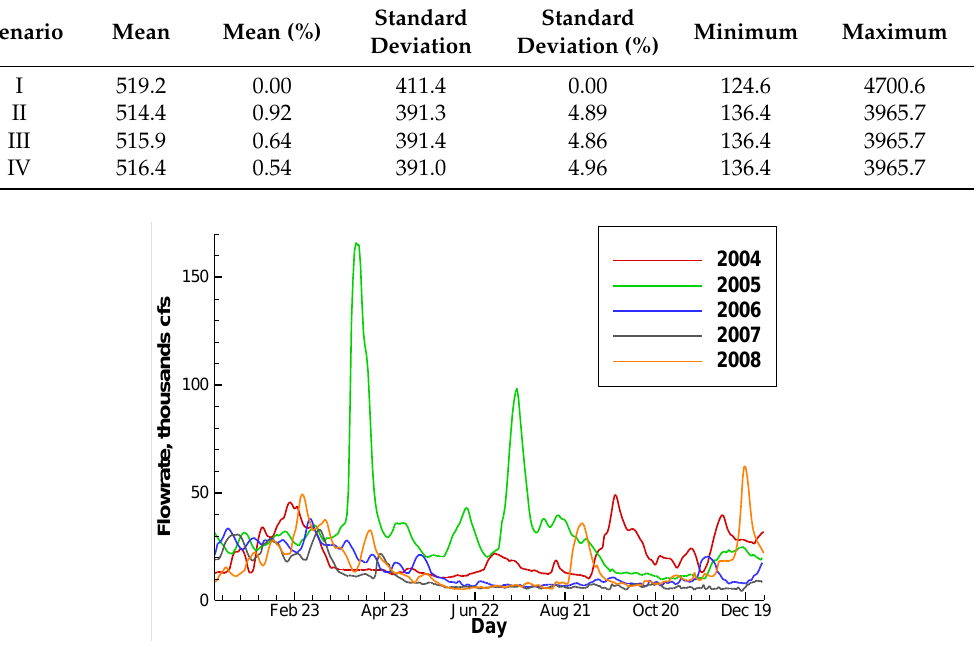
Figure 3. Observed flowrate (cfs) at Sumatra gage.